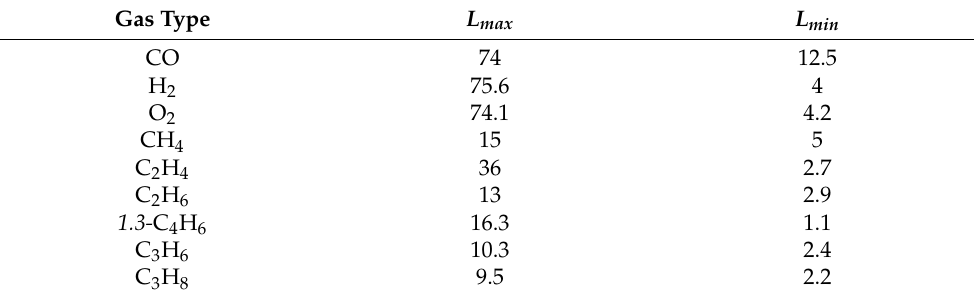
Table 5. Combustible limits of common combustible gases.